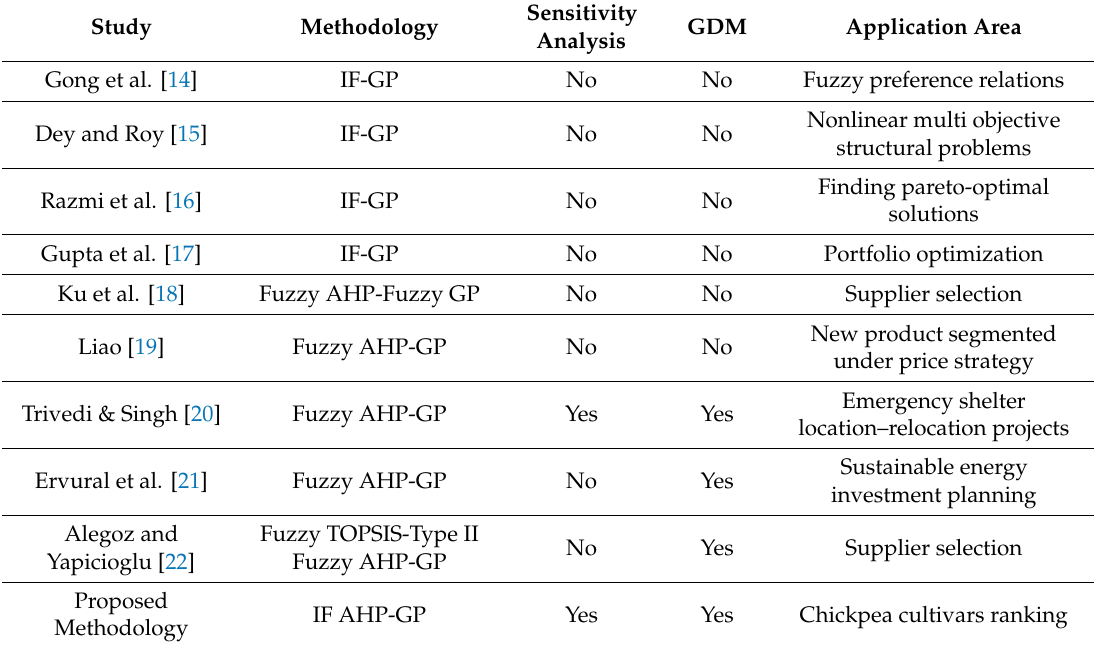
Table 1. A review for goal programming (GP)